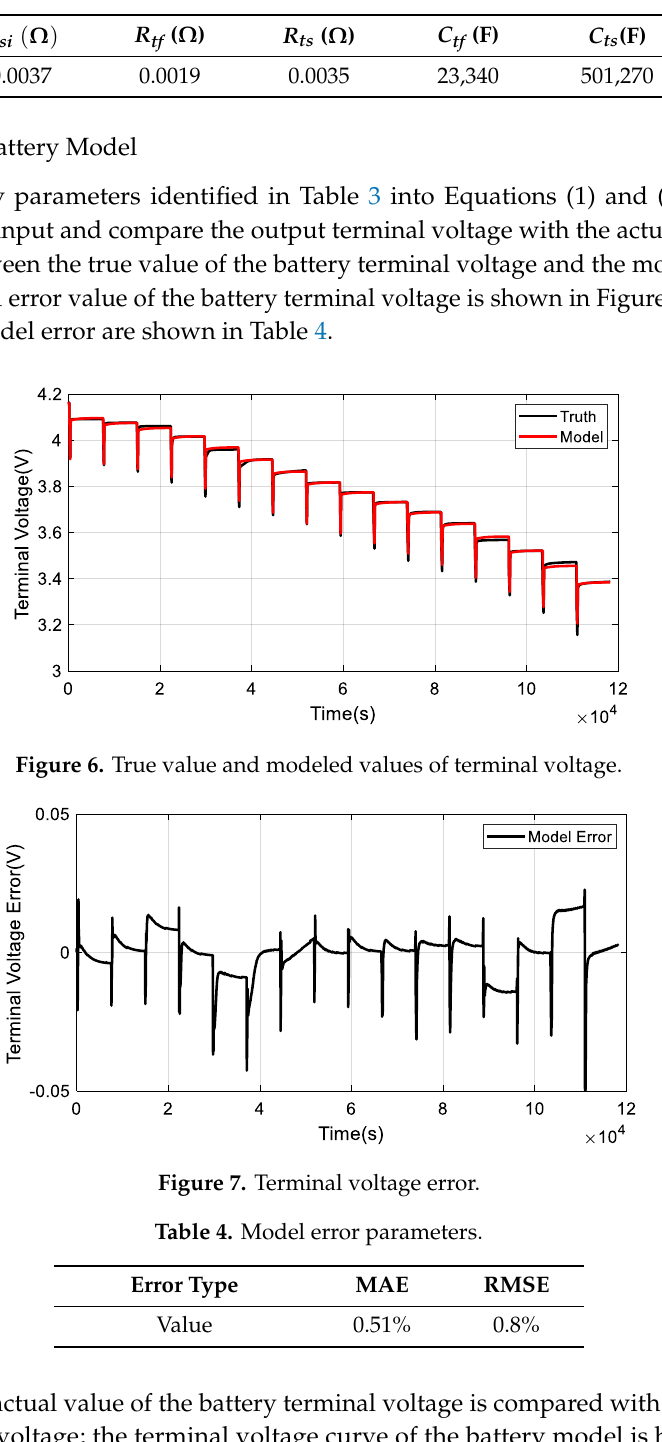
Table 3. Lithium-ion battery parameter identification results.